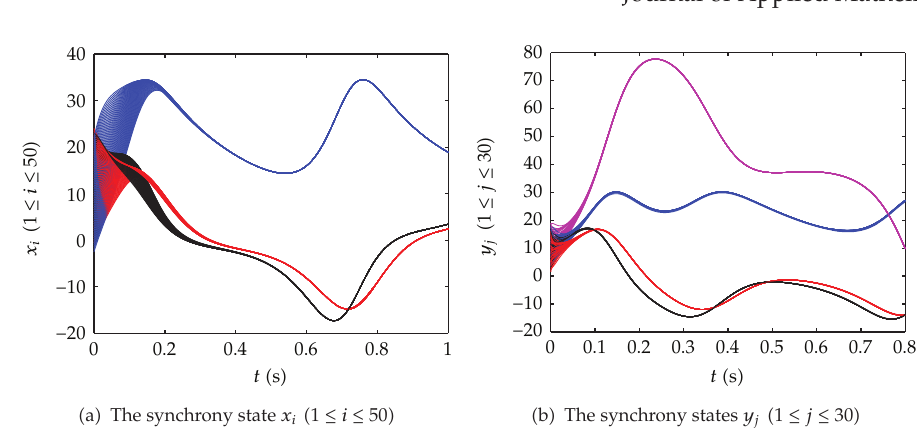
Figure 2: Cluster synchronization of the linearly coupled network (cid:4) 3.6 (cid:5) with 50 lorenz oscillators in the x -cluster and 30 hyperchaotic L¨u oscillators in the y -cluster.